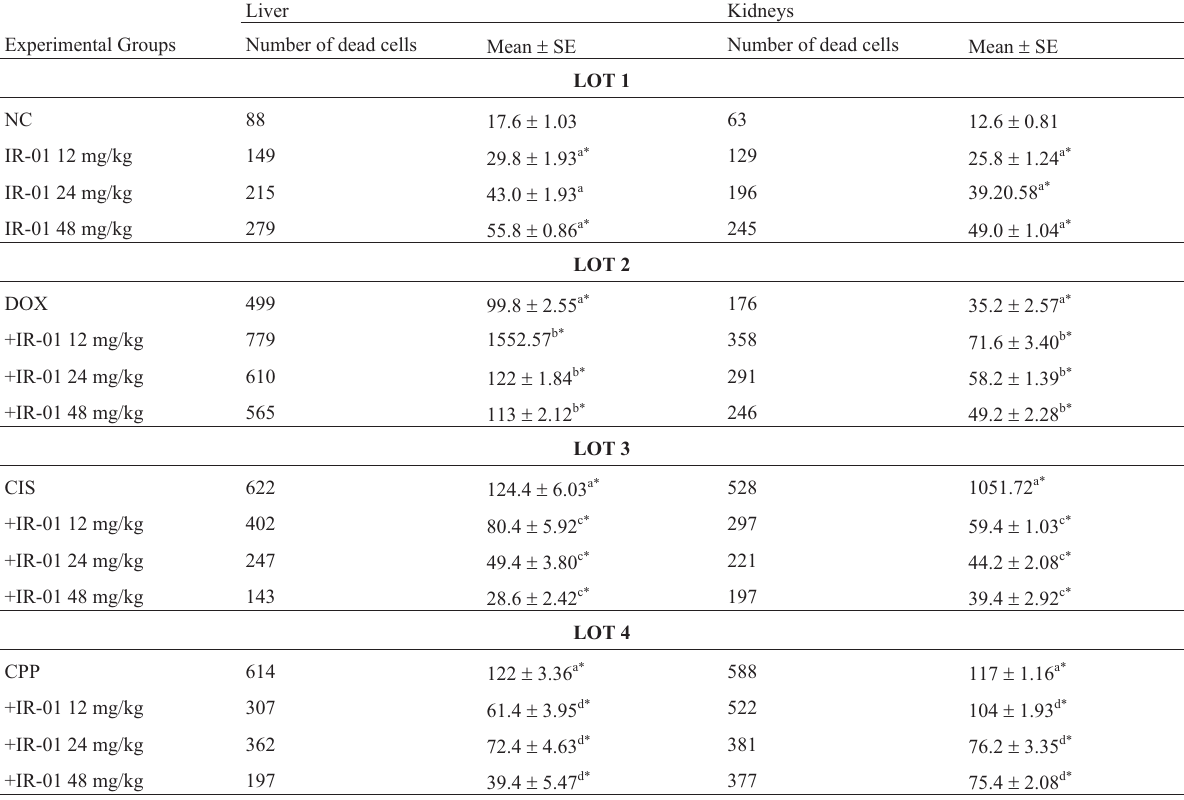
Table 5 - Cell death evaluation on mice kidneys and